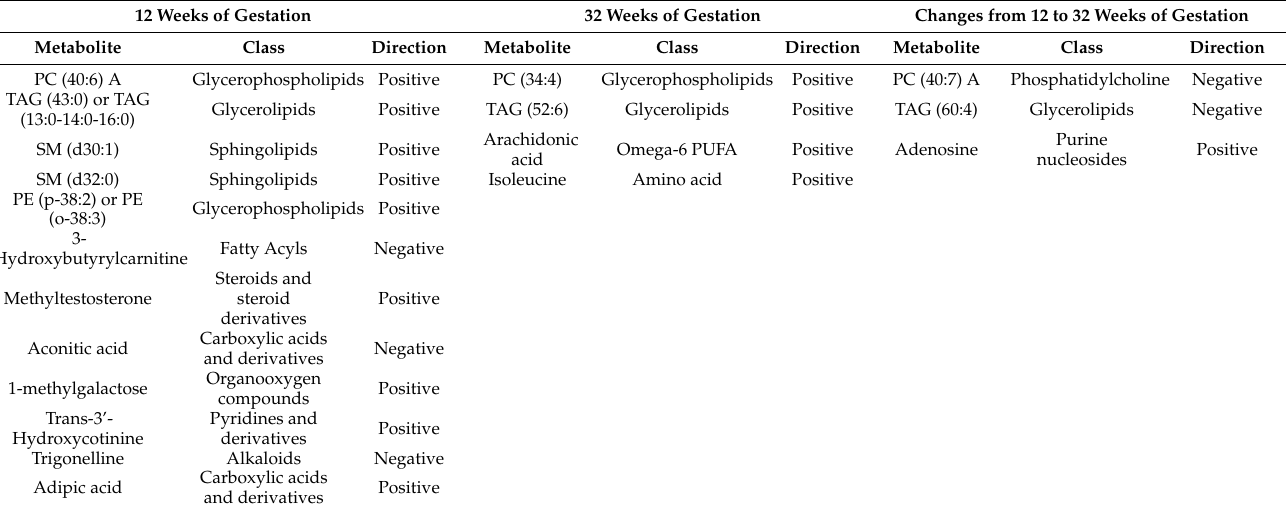
Table 2. Metabolite panels associated with total gestational weight gain in LASSO regression 1 .